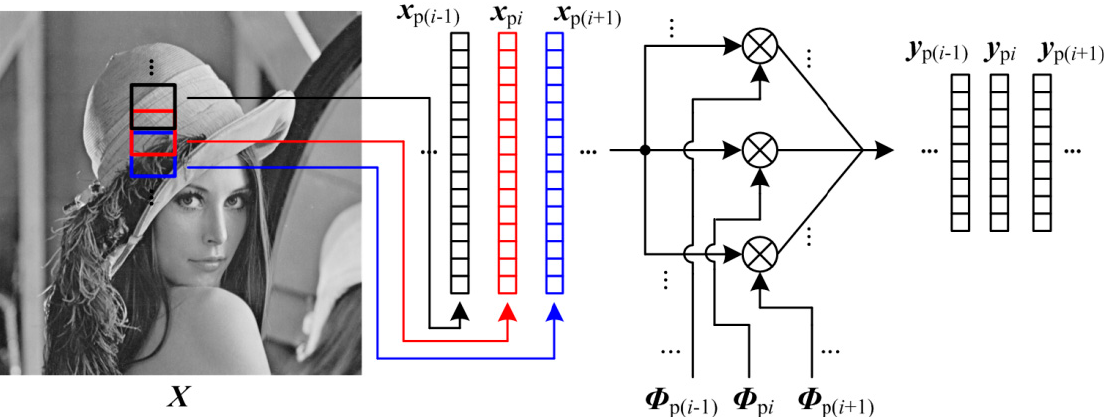
Figure 4. Illustration on PA format.